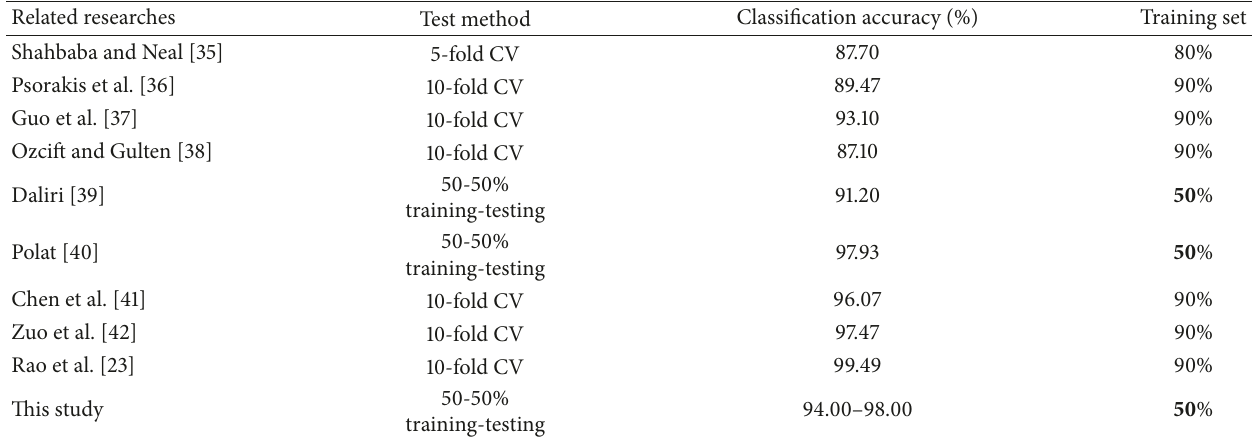
Table 9: Comparative experiment